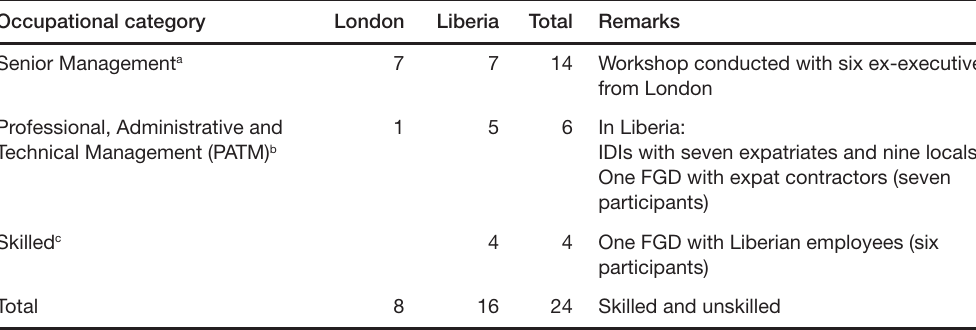
Table 1. Sample size and composition.